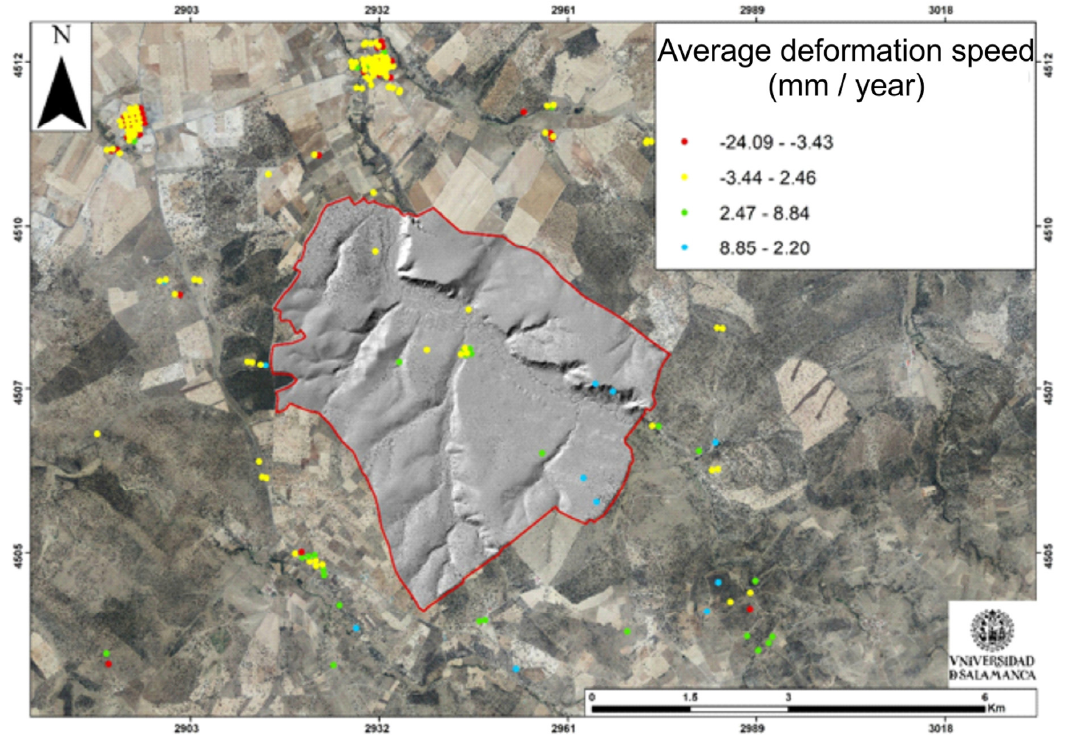
Figure 7. Cartography of mean deformations of the terrain indicating with colors the different speeds obtained from the satellite difference analyzed between images.